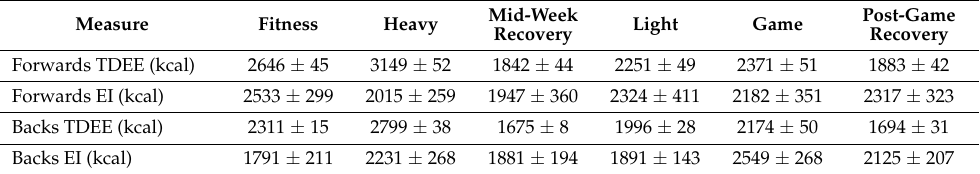
Table 5. Average daily energy expenditure and energy intake over 6 different load days for forwards and backs.